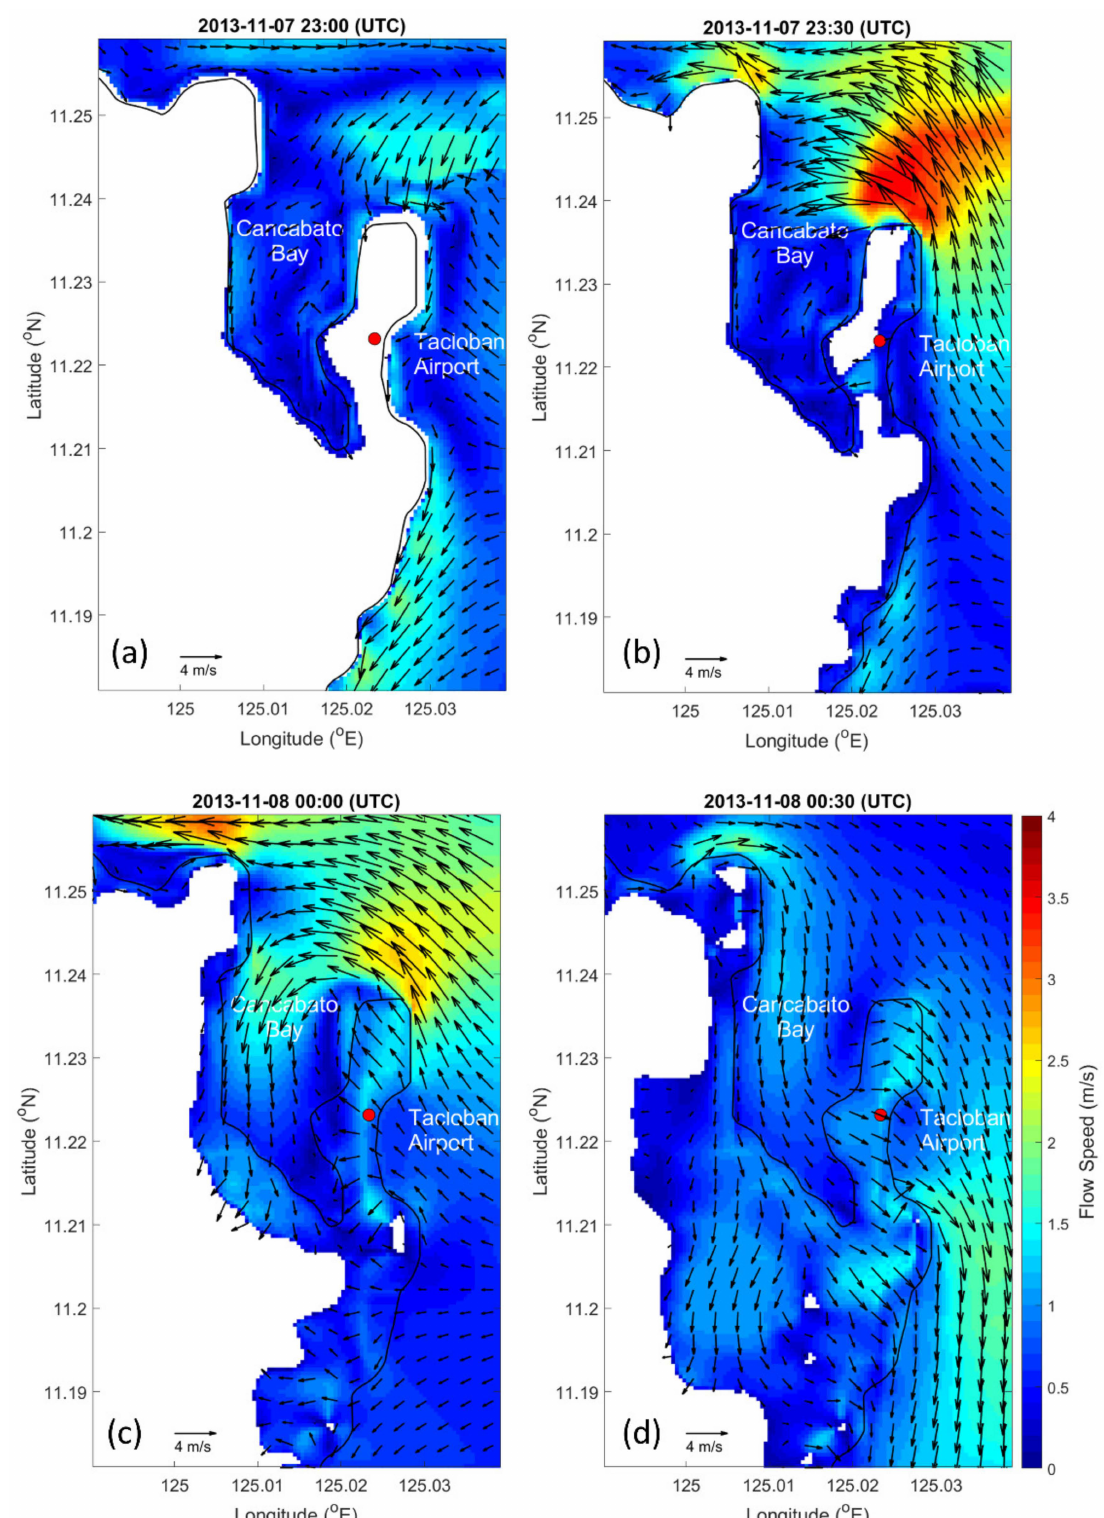
Figure 12. Computed storm-induced currents of Domain D03: ( a ) at 23:00 UTC on 7 November 2013; ( b ) at 23:30 UTC on 7 November 2013; ( c ) at 00:00 UTC on 8 November 2013; ( d ) at 00:30 UTC on 8 November 2013. The color shading indicates the flow speed in m/s. The black arrows show the flow velocities in m/s. The red circle shows the location of the Tacloban